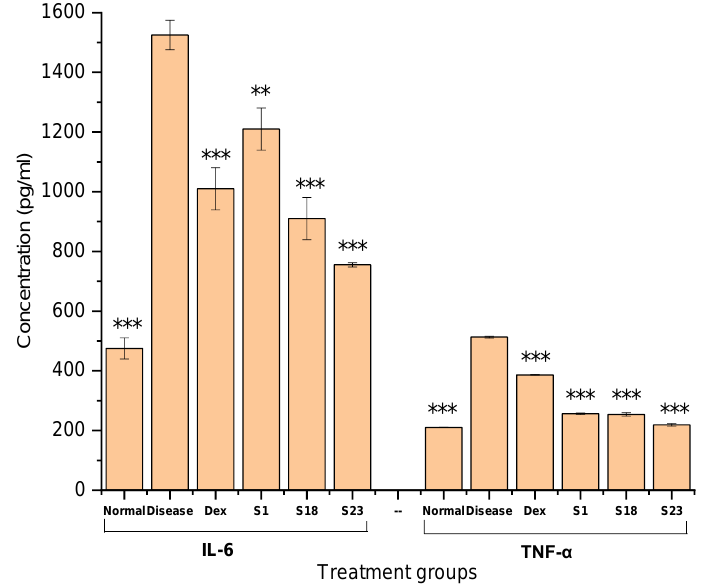
Figure 11. Serum IL-6 and TNF- α levels. The error bar designates the standard deviation (n = 3, p < 0.05). The data are represented as the mean ± S.D. The comparison with the diseased control group is denoted by ** (moderately significant) and *** (highly significant) at p < 0.01 and p < 0.001, respectively. Here, normal refers to the group, which did not receive carrageenan and treatment.